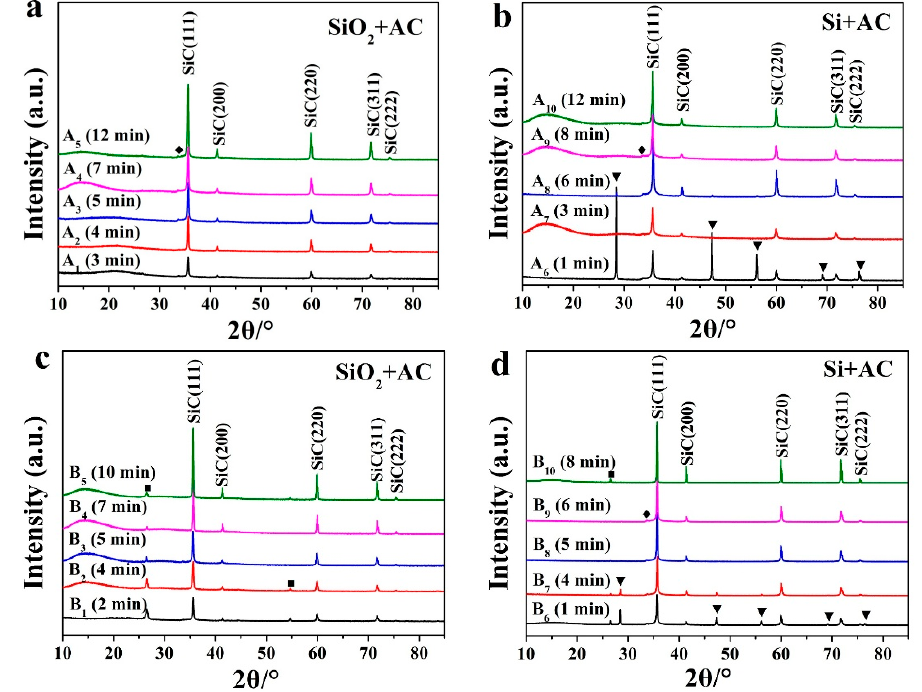
Figure 2. XRD patterns of β -SiC samples synthesized in RMMC reactor. Reflections from silicon ( ▼ ), graphite ( ■ ) and stacking faults in β -SiC ( ◆ ) are indicated. Microwave susceptor: ( a , b ) AC and ( c , d ) graphite.